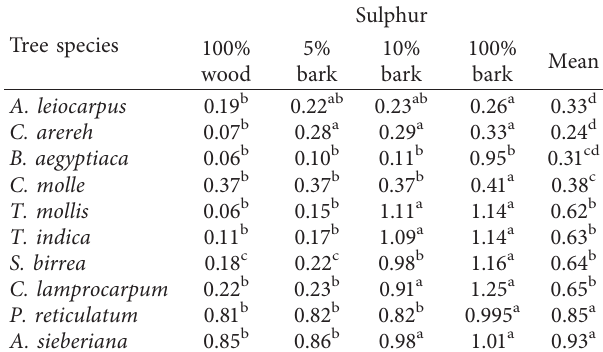
Table 3: Effect of bark inclusion on the oxygen content (%) of the selected fuelwood species. Tree species